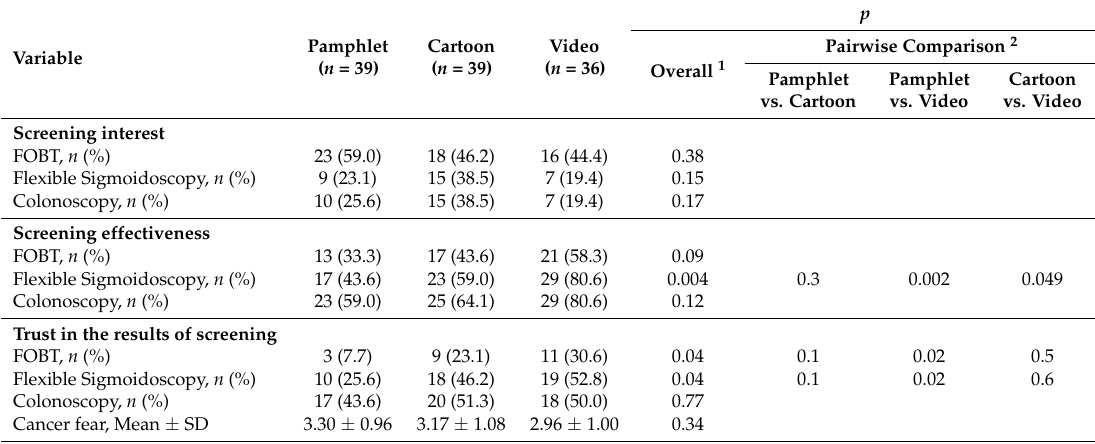
Table 3. Results on attitudes towards CRC screening methods and cancer fear by